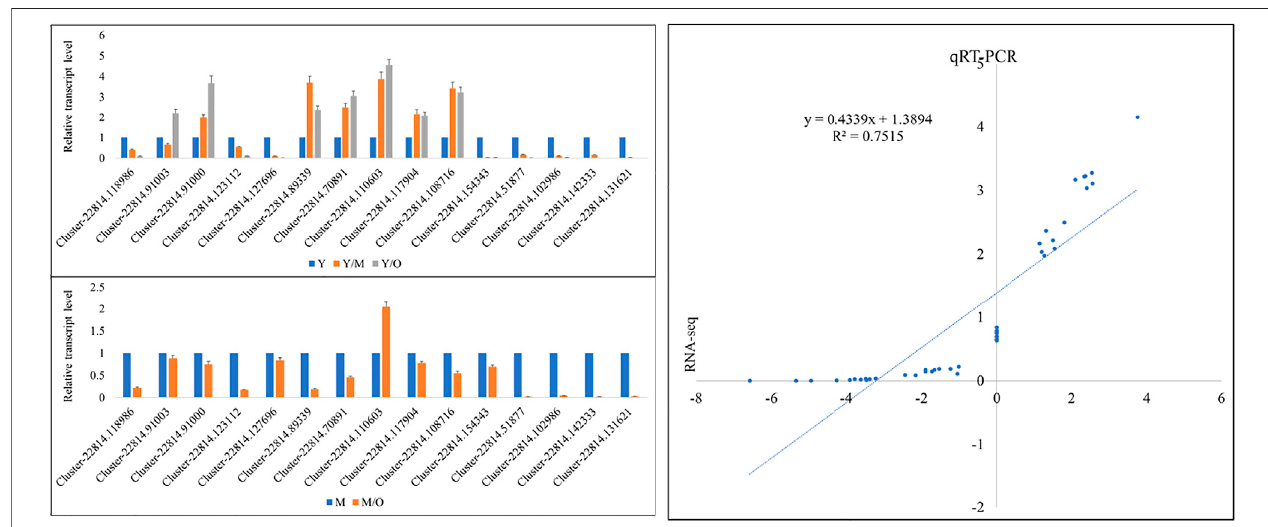
FIGURE 6 | qRT-PCR analysis of selected DEGs in young (Y), mature (M), and old (O) Z. of fi cinalis rhizomes. Y/M, Y/O, and M/O shows relative change in the expression. The panel on the right side shows correlation between FPKM values and qRT-PCR data.